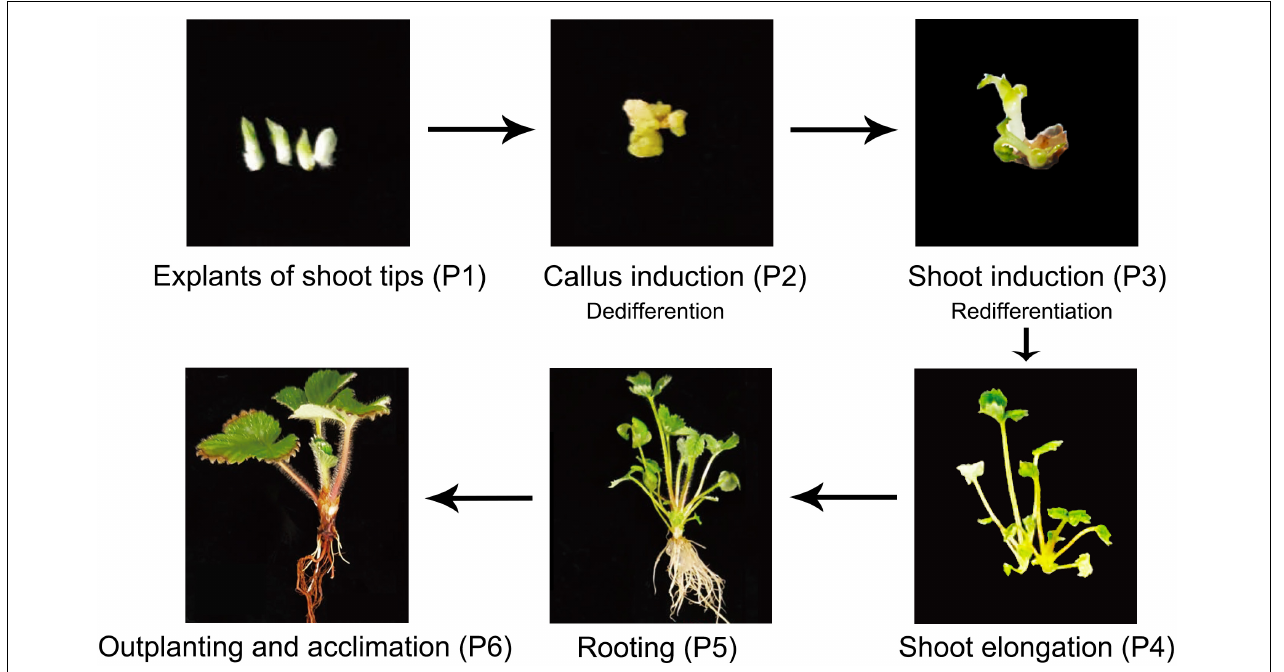
FIGURE 1 | Plant materials used in this study. Plant regeneration of F. nilgerrensis from explants of shoot tips to outplanting and acclimation.